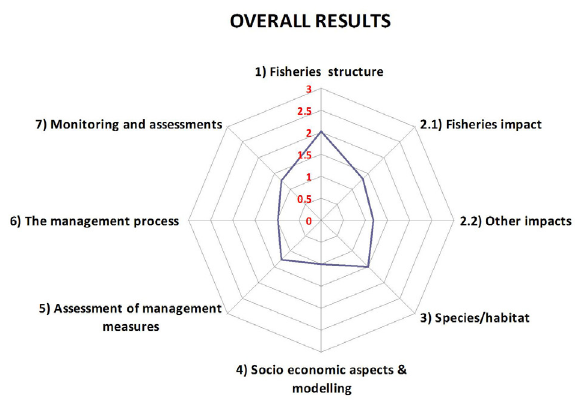
Fig. 2. – Radar graph showing the overall overview of the expert evaluation on the capacity to address the EAF issues. Scores range from 0 to 3 (from null to high capacity to address each issue related to the EAF).